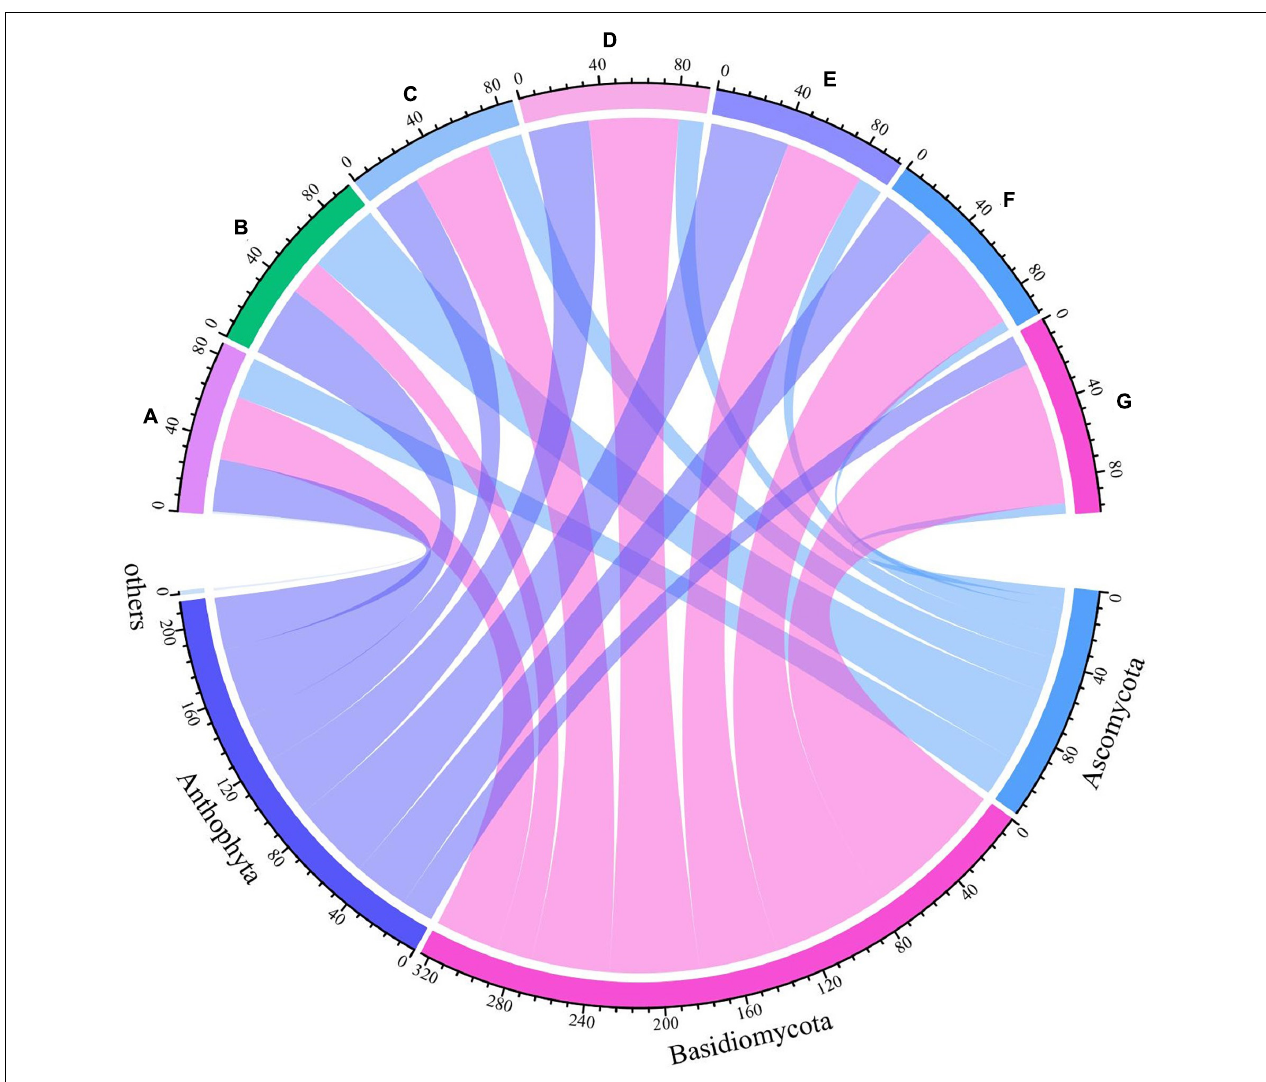
FIGURE 5 | Differences in fungal communities on Cabernet Sauvignon grapes at different growth stages at the phylum levels.